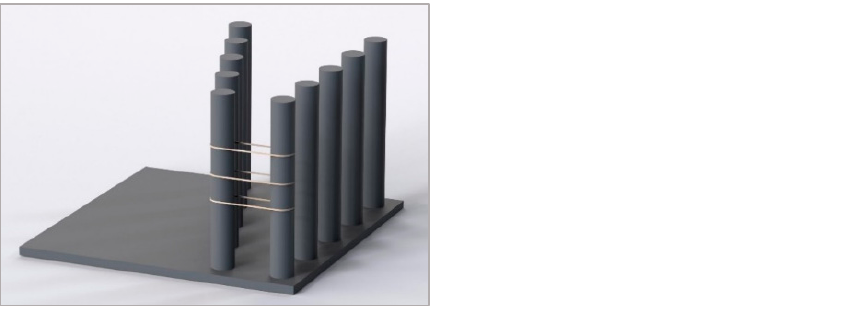
Figure 2. Three-dimensional model of a board with spurs for the standardization of the elastic stretch.